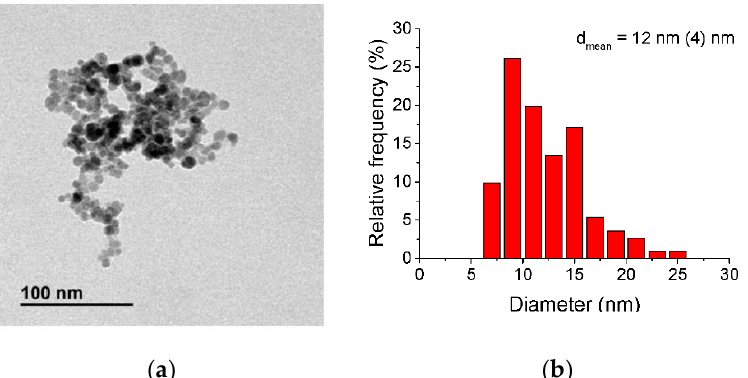
Figure 1. ( a ) Transmission electron microscopy (TEM) images of nanoparticles (NPs) electrochemically synthesised and ( b ) particle size distribution.